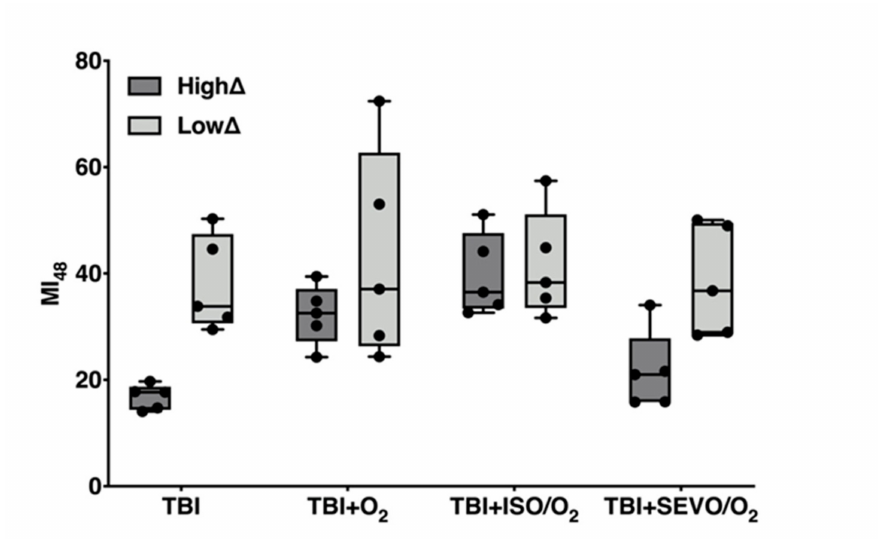
Figure A2. Averaged MI 48 for high ∆ and low ∆ groups. Box plots of the MI 48 for the five lines in the high ∆ and low ∆ groups under the indicated treatment conditions. Horizontal bars indicate the median, and whiskers extend to the minimum and maximum data points.